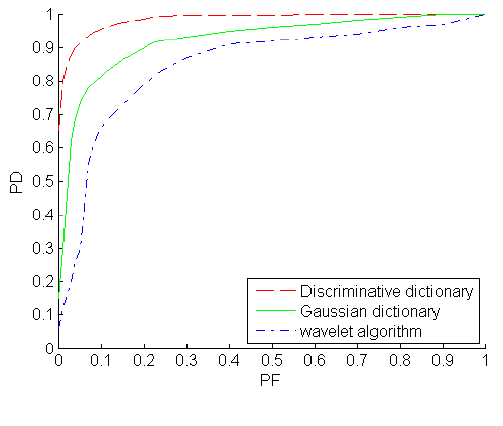
Figure 17. ROC curves of target